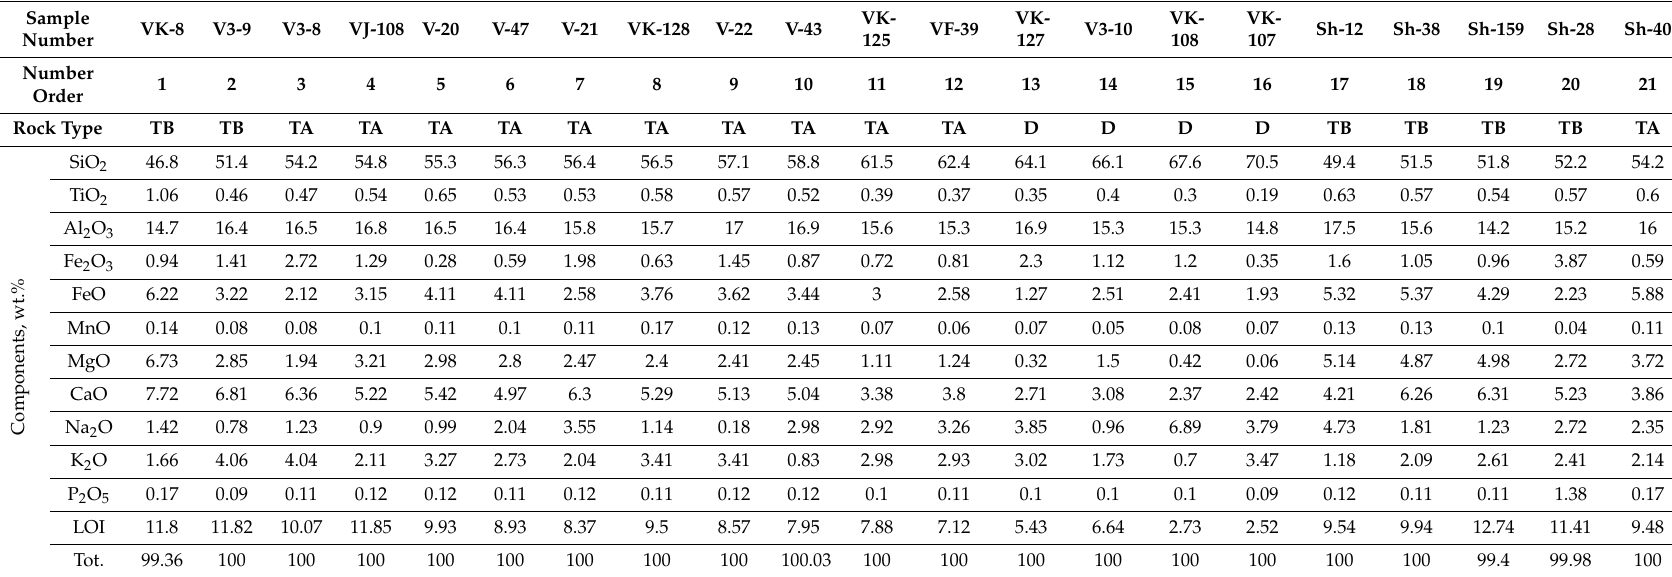
Table 2. Major element compositions of studied igneous rocks from the Vyun and Shumniy